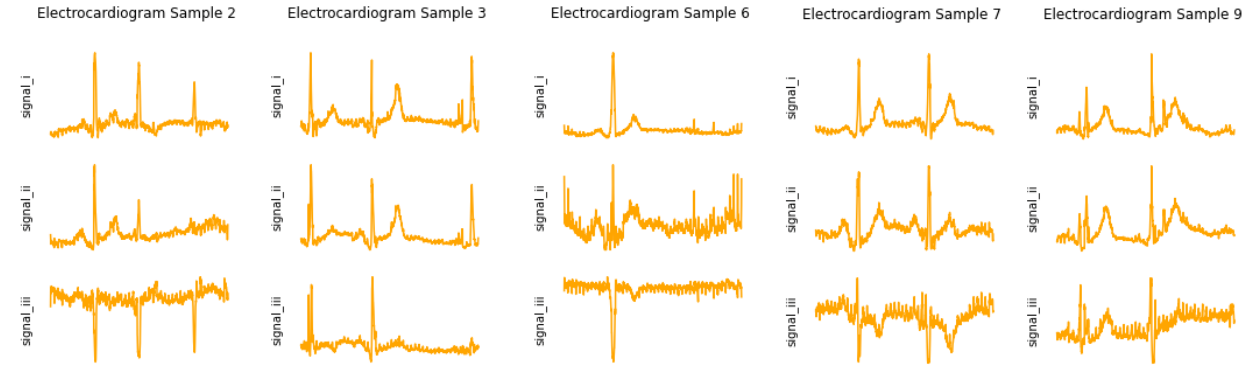
Figure 19. Generated electrocardiograms after 200 epoch training using the RGB data arrangement with label